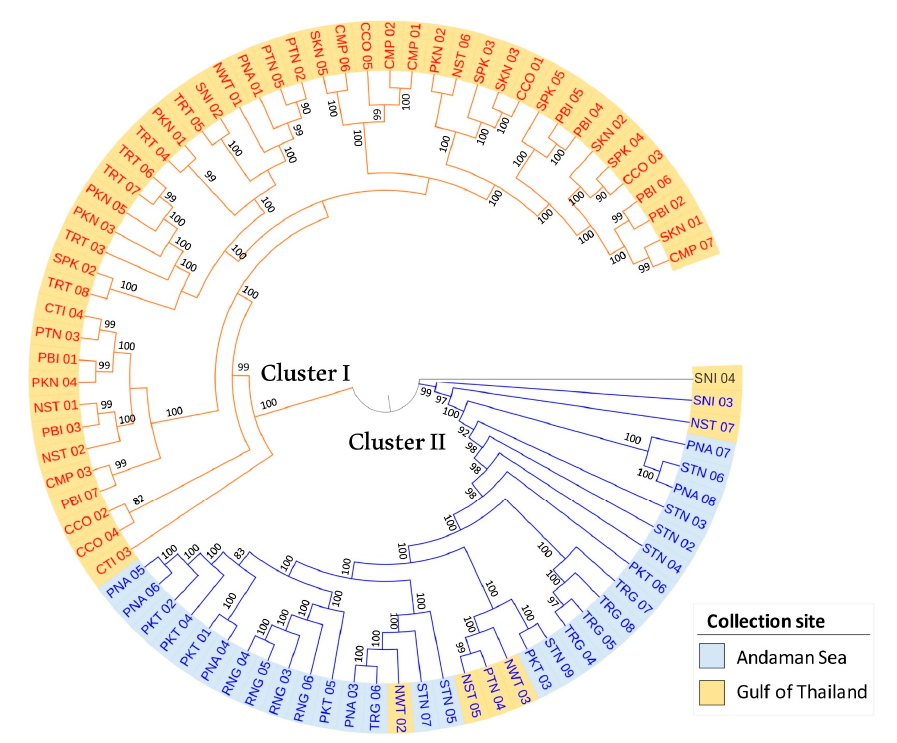
Figure 5. Maximum likelihood dendrogram of 82 R. apiculata accessions based on 2640 SNPs. Num- bers at the nodes are bootstrap values estimated by permutation test with 1000 replicates. The accessions labeled in red and blue texts represent the first (cluster I) and second (cluster II) groups of R. apiculata according to the STRUCTURE analysis, respectively. Blue and yellow highlights indicate collection sites at the Andaman Sea and the Gulf of Thailand, respectively.